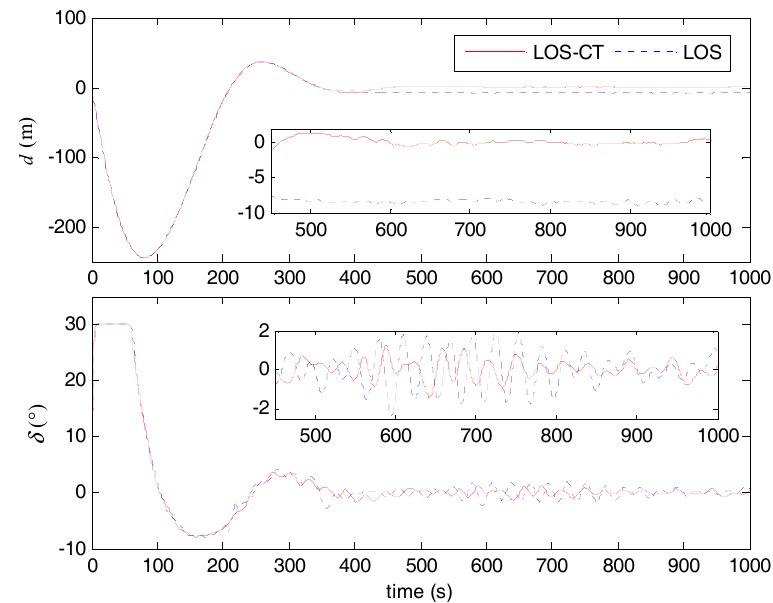
Figure 8. The path following results in X - Y plane.